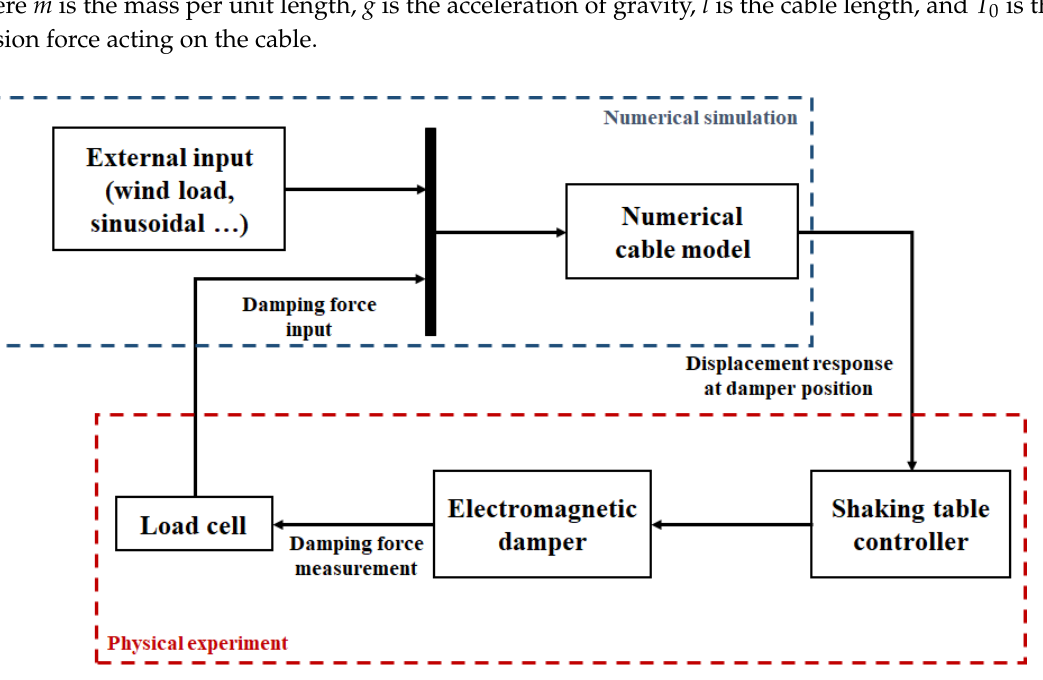
Figure 7. Block diagram of the hybrid simulation.